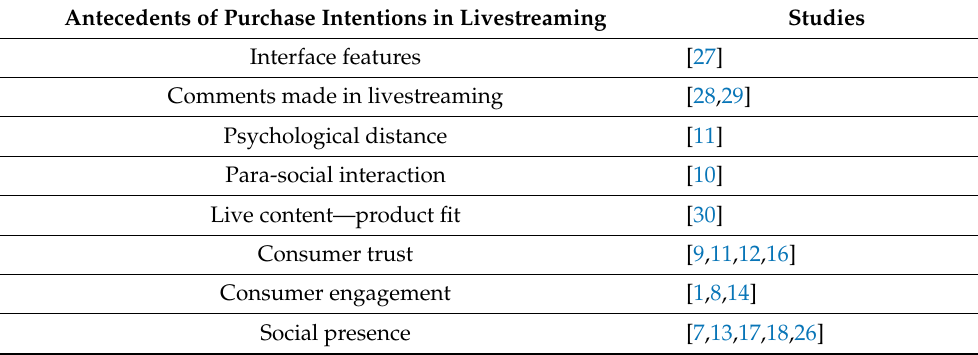
Table 1. A summary of antecedents of purchase intentions in livestream